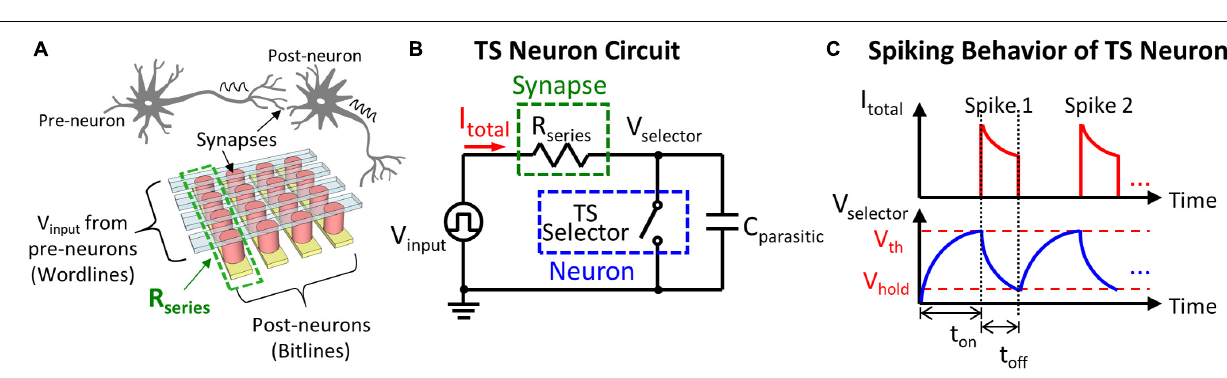
FIGURE 2 | (A) Inspired by the biological neural network, neurons are connected with synapses through bit lines and word lines in the crossbar memory array. V input received from the pre-neurons is applied on the word lines, and the post-neurons connected to bit lines generate output spikes according to the weight of synapses. (B) Equivalent circuit of the measurement setup where the synaptic devices along the same bit line (with a total resistance of R series ) are connected in series with a TS selector as a neuron. A parasitic capacitor C parasitic is considered and is connected in parallel with the TS neuron. (C) The evolution of I total and V selector shows the spiking behavior of the TS neuron when V input is applied due to the charging and discharging of C parasitic . t on and t off define the required period of time for the TS selector to turned on and off in the neuron circuit,